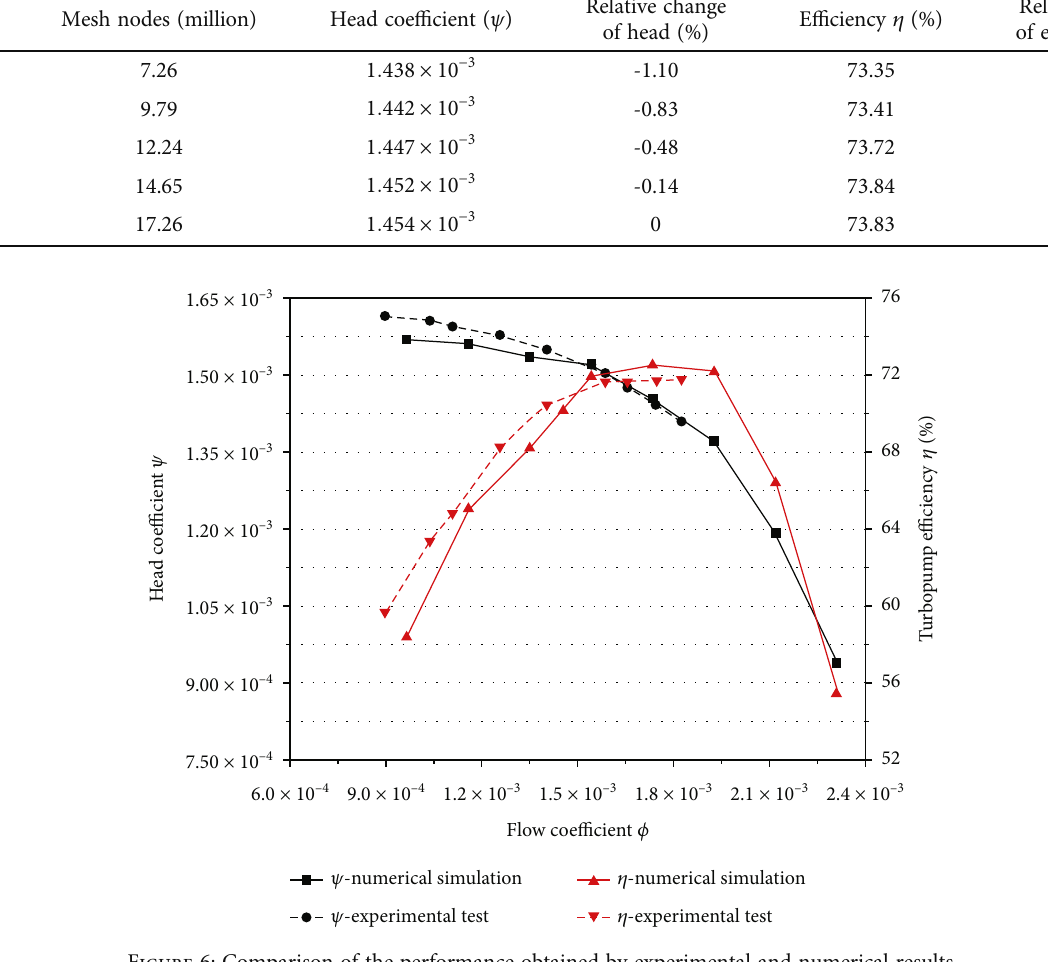
Figure 6: Comparison of the performance obtained by experimental and numerical